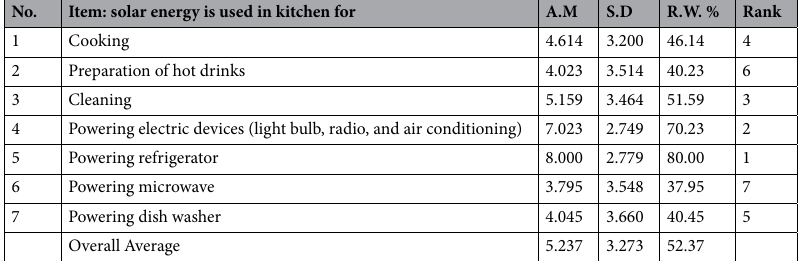
Table 2. Distribution of participant’s response to the usage of solar energy in the kitchen.